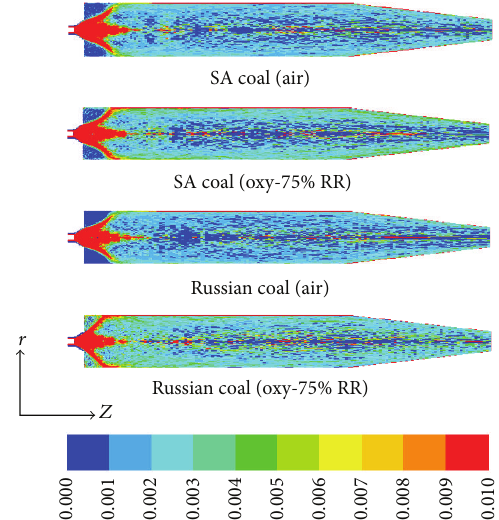
Figure 5: Contours of particle concentrations (in kg/m 3 ) during the combustion of Russian and SA coal in air and in the oxy-75% RR scenario.